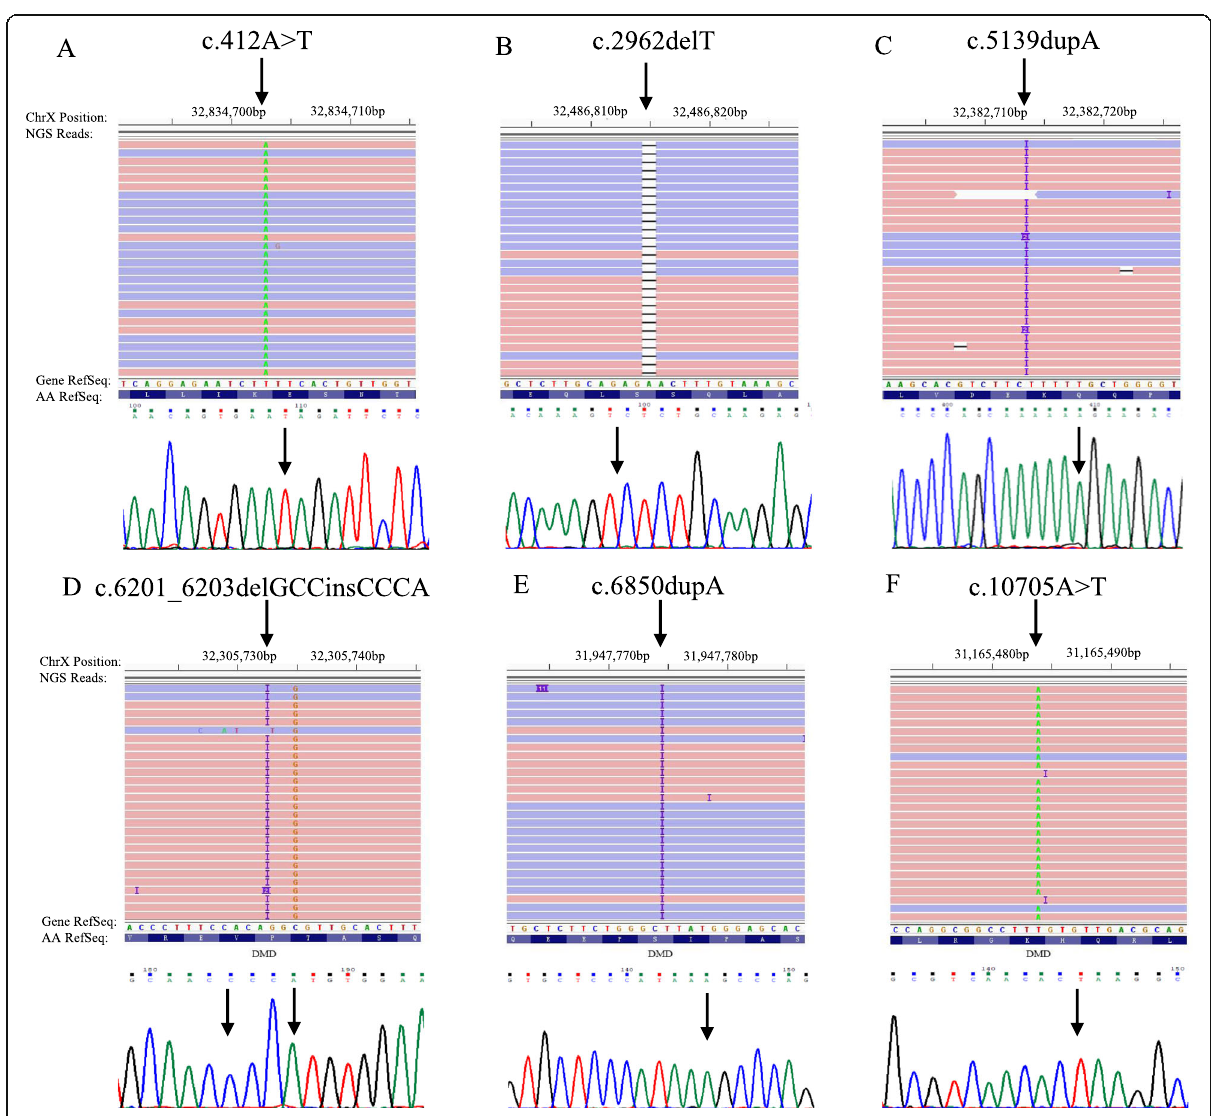
Fig. 2 Novel mutations were detected using NGS and verified by Sanger sequecing. NGS reads were shown on the Integrative Genomics Viewer. a showed the novel mutation of c.412A>T; b showed the novel mutation of c.2962delT; c showed the novel mutation of c.5139 dupA; d showed the novel mutation of c.6201_6203 delGCCinsCCCA; e showed the novel mutation of c.6805dupA; f showed the novel mutation of 10705A